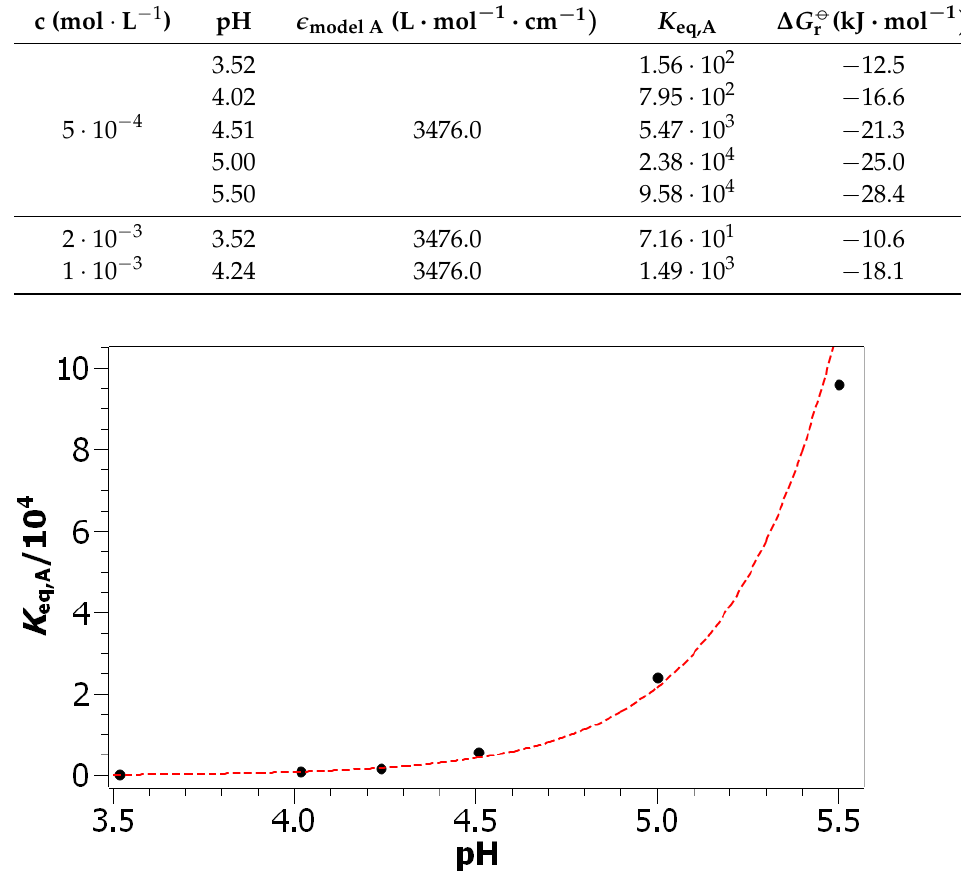
Figure 4. Dependence of the formation constant of the coordination compound [GAFe(II)] 2 + on the pH of the acetate